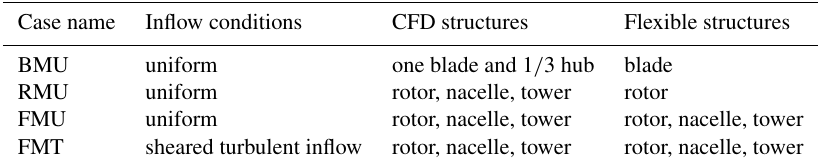
Figure 3. Explicit coupling strategy. Table 3. Computed cases with inflow condition, CFD modeled structures and